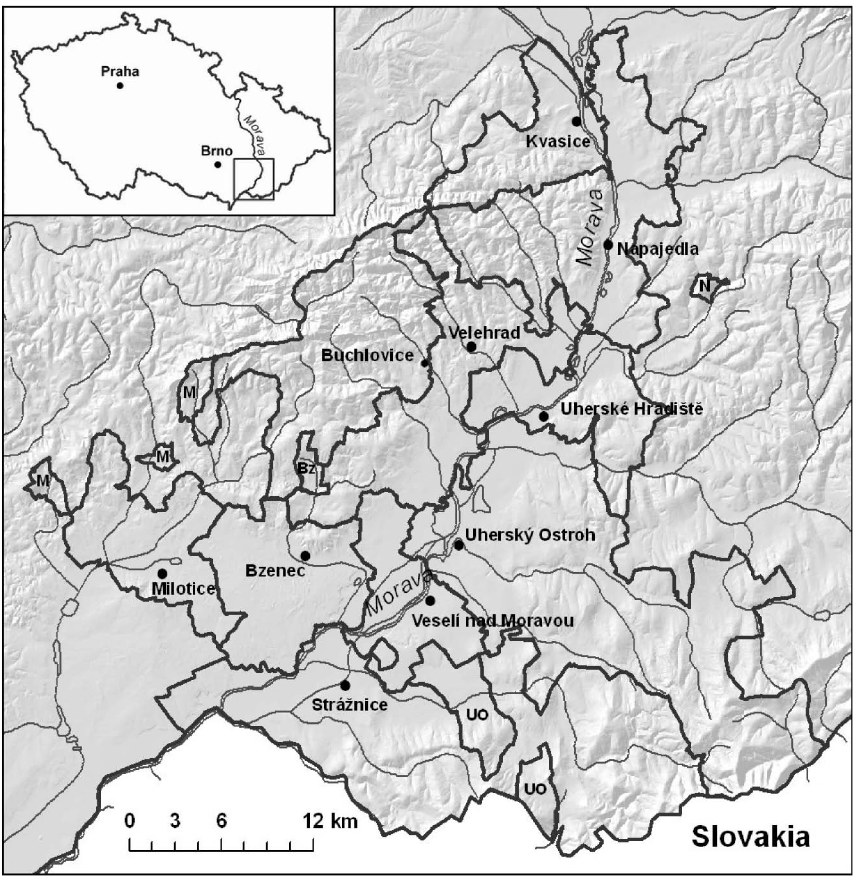
Fig. 1. The area studied, with borders of the individual estates and their administrative centres (smaller areas belonging to a particular estate are marked as Bz – Bzenec, M – Milotice, N – Napajedla, UO – Uhersk´y